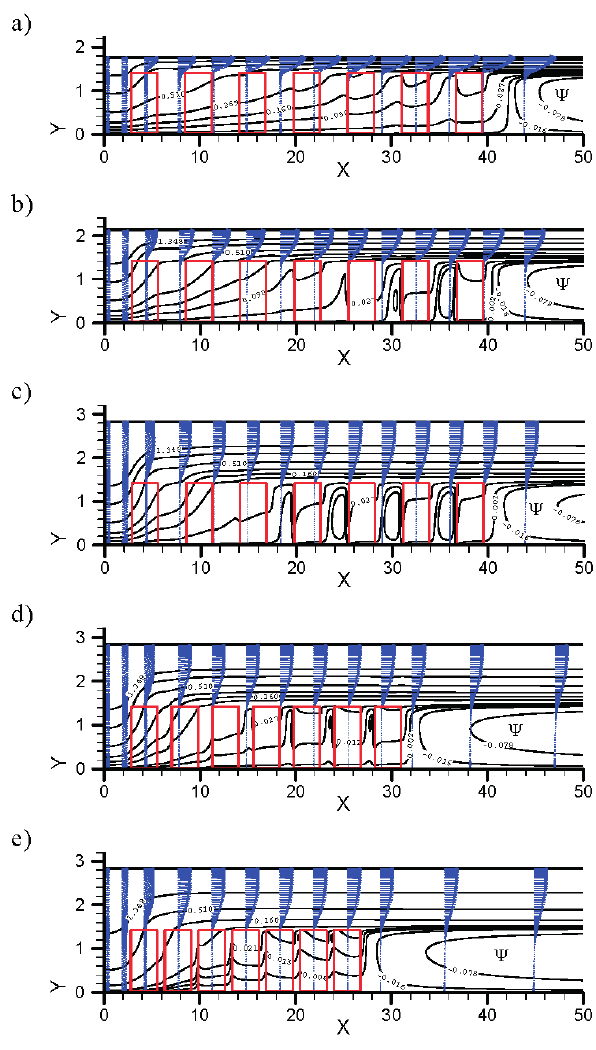
Figure 9. Streamlines and velocity vectors for test Sample 1 with various values of X T * and X L * (the scales of X -axis and Y -axis are different): ( a ) X T * = 1.25; X L * = 2; ( b ) X T * = 1.5; X L * = 2; ( c ) X T * = 2; X L * = 2; ( d ) X T * = 2; X L * = 1.5; and ( e ) X T * = 2; X L * =